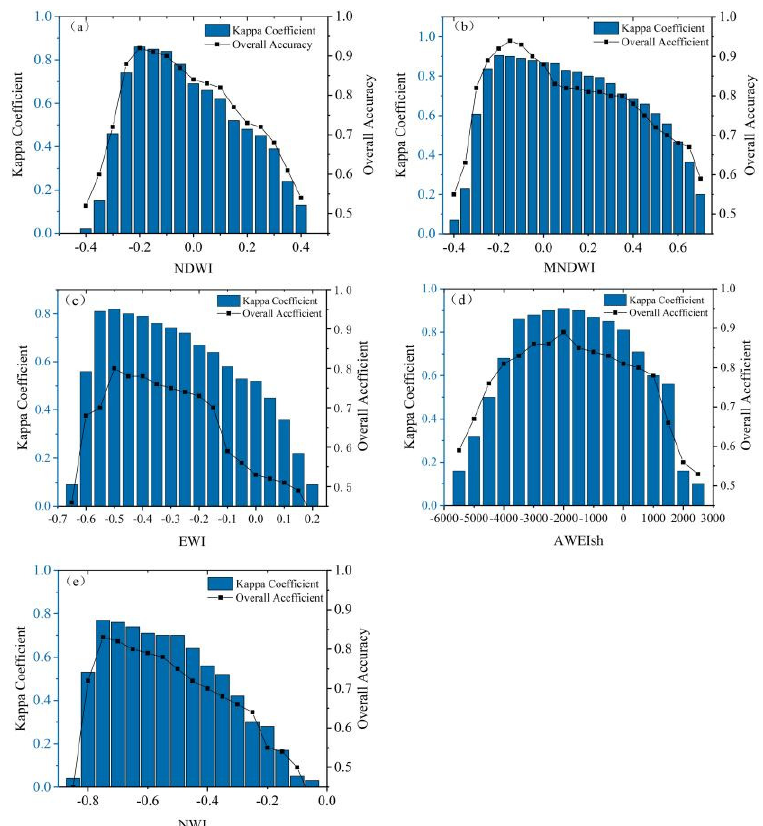
Figure 6. Accuracy of threshold experiments: ( a ) NDWI threshold test, ( b ) MNDWI threshold test, ( c ) EWI threshold test, ( d ) AWEIsh threshold test, ( e ) NWI threshold